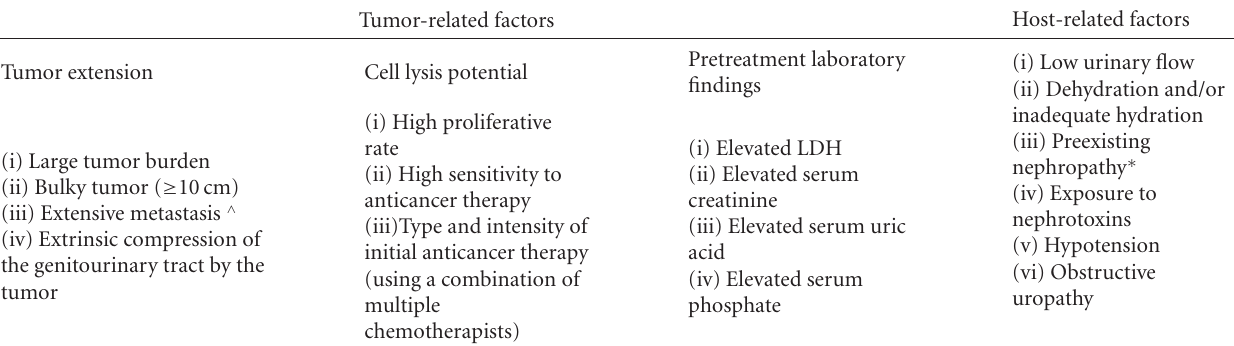
Table 4: Risk factors for tumor lysis syndrome is solid tumors.